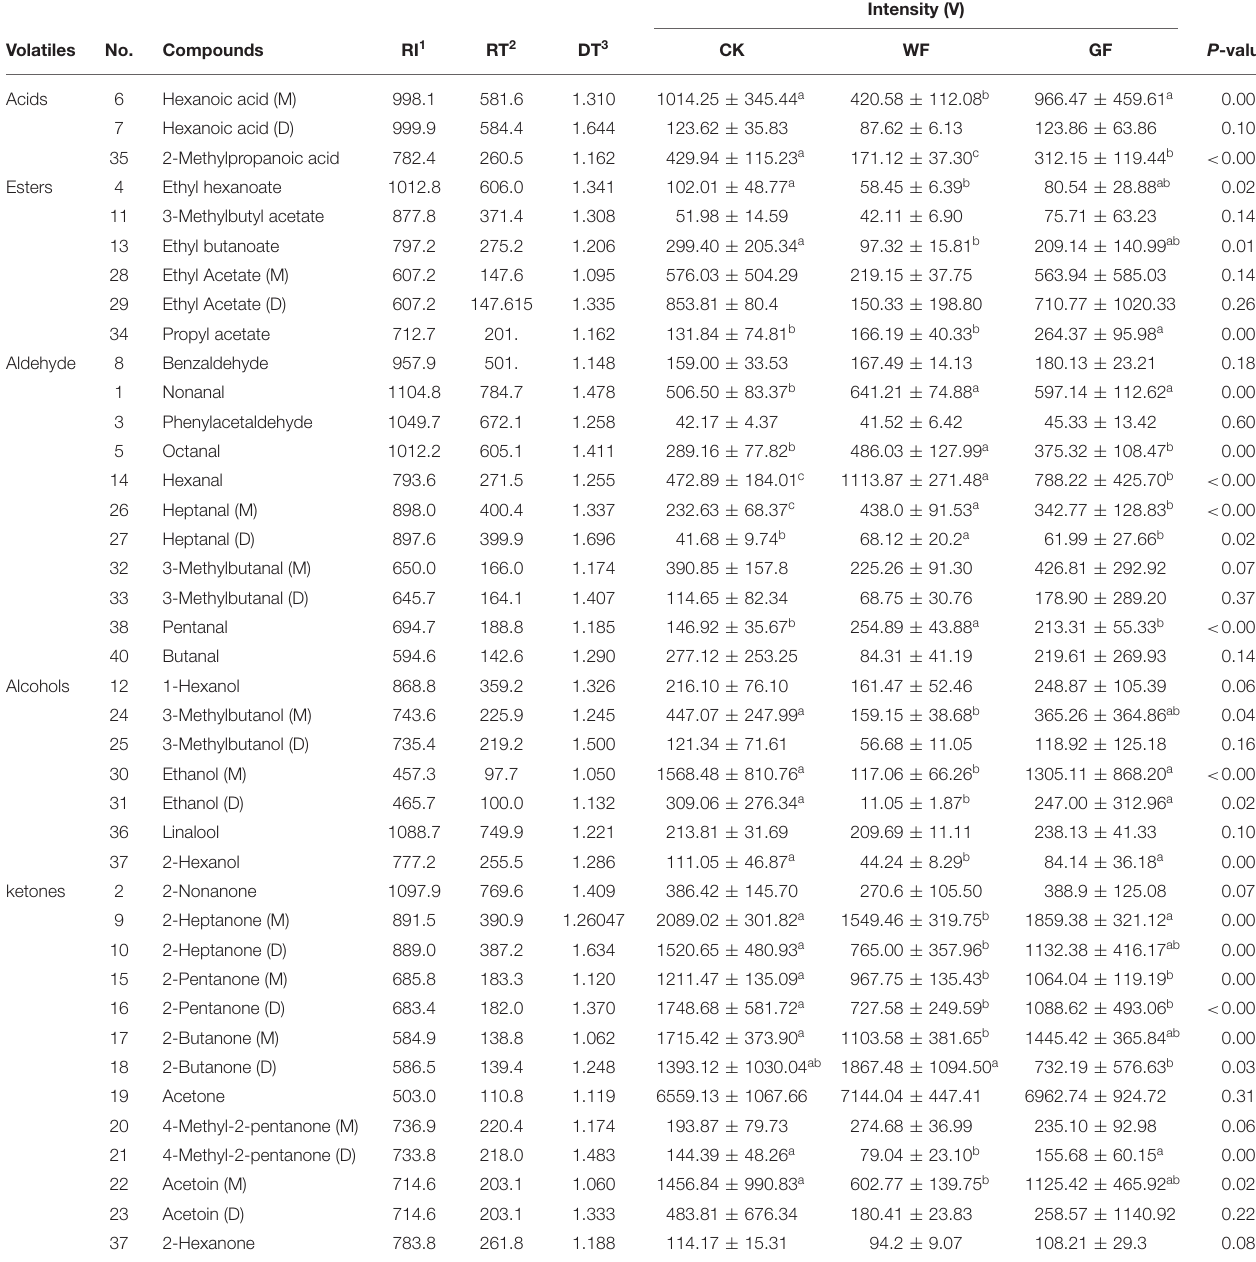
TABLE 1 | Compounds identified in raw milk from cows fed different diets by GC-IMS (Mean ±